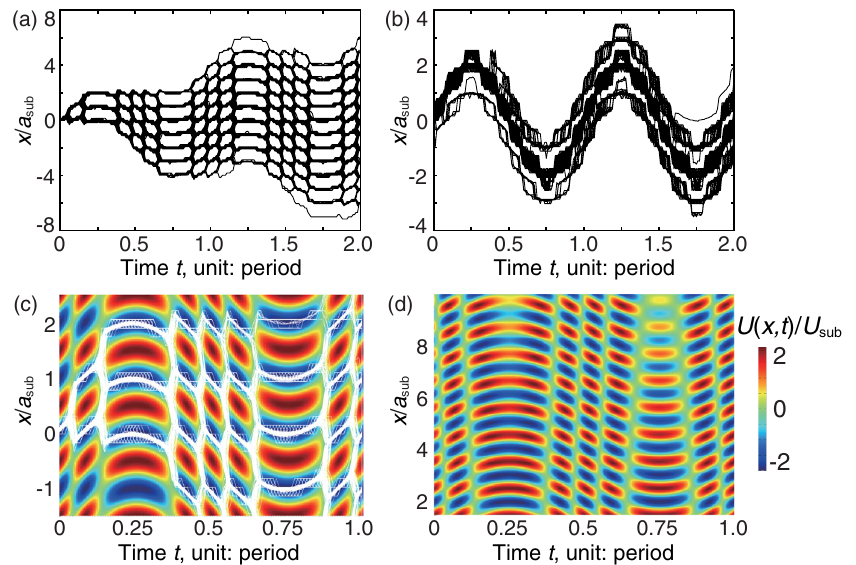
FIG. 2. Mechanisms of enhanced diffusion. (a),(b) Trajectories of adsorbates calculated for commensurate surfaces oscillating with =a ¼ 0 . 95 ) with f=f ¼ 1 . 26 × 10 − 5 , respectively. The frequency f=f 0 ¼ 1 . 26 × 10 − 2 and for incommensurate surfaces ( a 0 sub sld oscillation amplitude is A ¼ 2 a . The time interval in (a) and (b) corresponds to two periods of oscillations. Note that different scales of sld the Y axis are used for better visualization. (c),(d) Time evolution of the potential energy experienced by particles U ð x; t Þ for commensurate and incommensurate ( ε ¼ 0 . 05 ) surfaces, respectively. Blue and red regions correspond to potential minima and maxima, respectively. The color bar is shown to the right of (d). The time interval in (c) and (d) corresponds to one period of oscillations. White curves in (c) show trajectories of